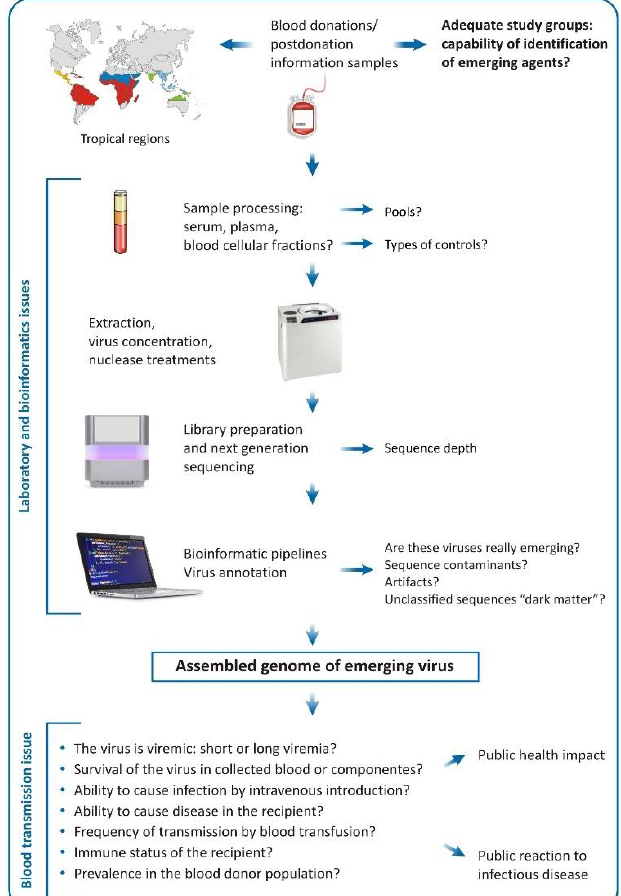
Figure 1. Schematic workflow (pipeline) for identification of emerging viruses in blood donations.